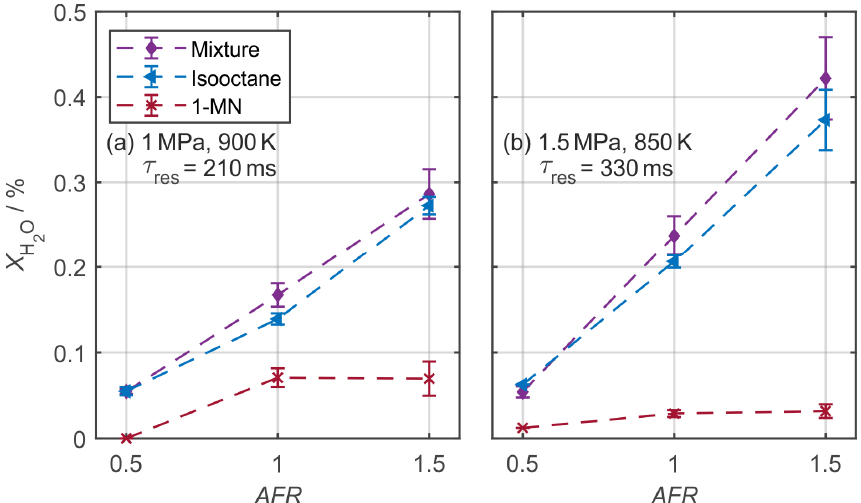
Figure 5. Air-fuel ratio dependency for pure isooctane, 1-MN and 1 vol. % 1-MN in isooctane, for two operating points ( a , b ).